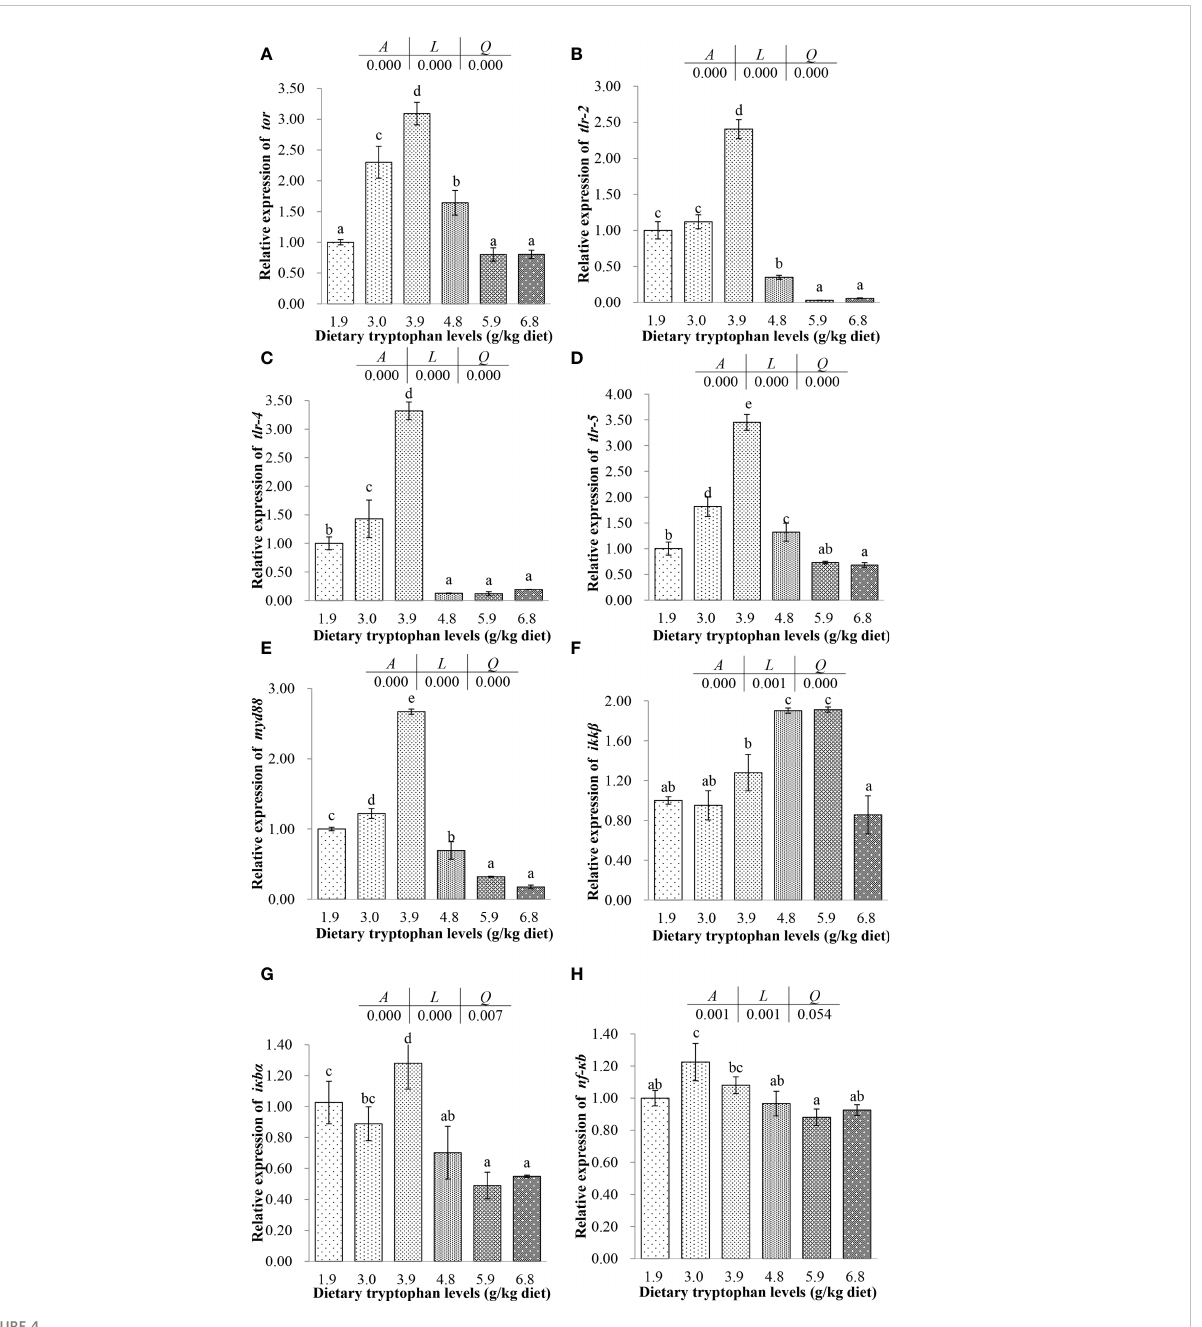
FIGURE 4 Effects of dietary tryptophan with different levels on the relative mRNA expression of genes related to the TOR and NF- k B signaling pathways of C argus intestine (means ± S.D. of three replications). Bars with different letters differ signi fi cantly among the treatments ( P < 0.05). (A) Target of rapamycin ( tor ); (B) Toll-like receptor-2 ( tlr-2 ); (C) Toll-like receptor-4 ( tlr4 ); (D) Toll-like receptor-5 ( tlr5 ); (E) Myeloid differentiation factor88 ( myd88 ); (F) Inhibitor of nuclear factor kappa B kinase beta subunit ( ikk b ); (G) Inhibitor of kappa B ( i k b a ); (H) Nuclear factor- k -gene binding ( nf- k b